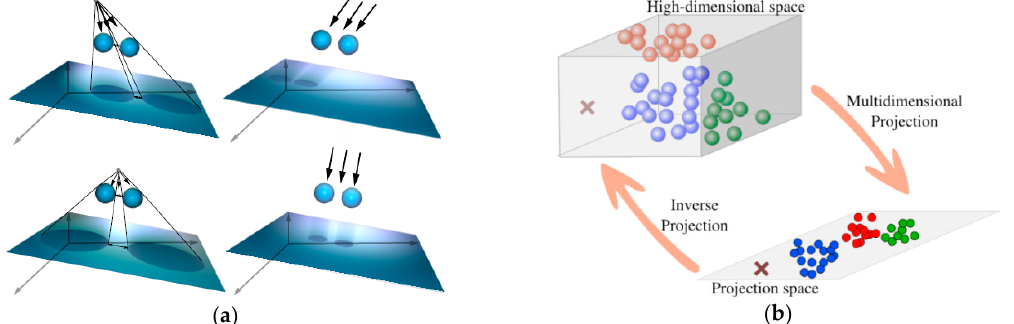
Figure 25. ( a ) Various projection modes [74]; and ( b ) inverse projection workflow [73].